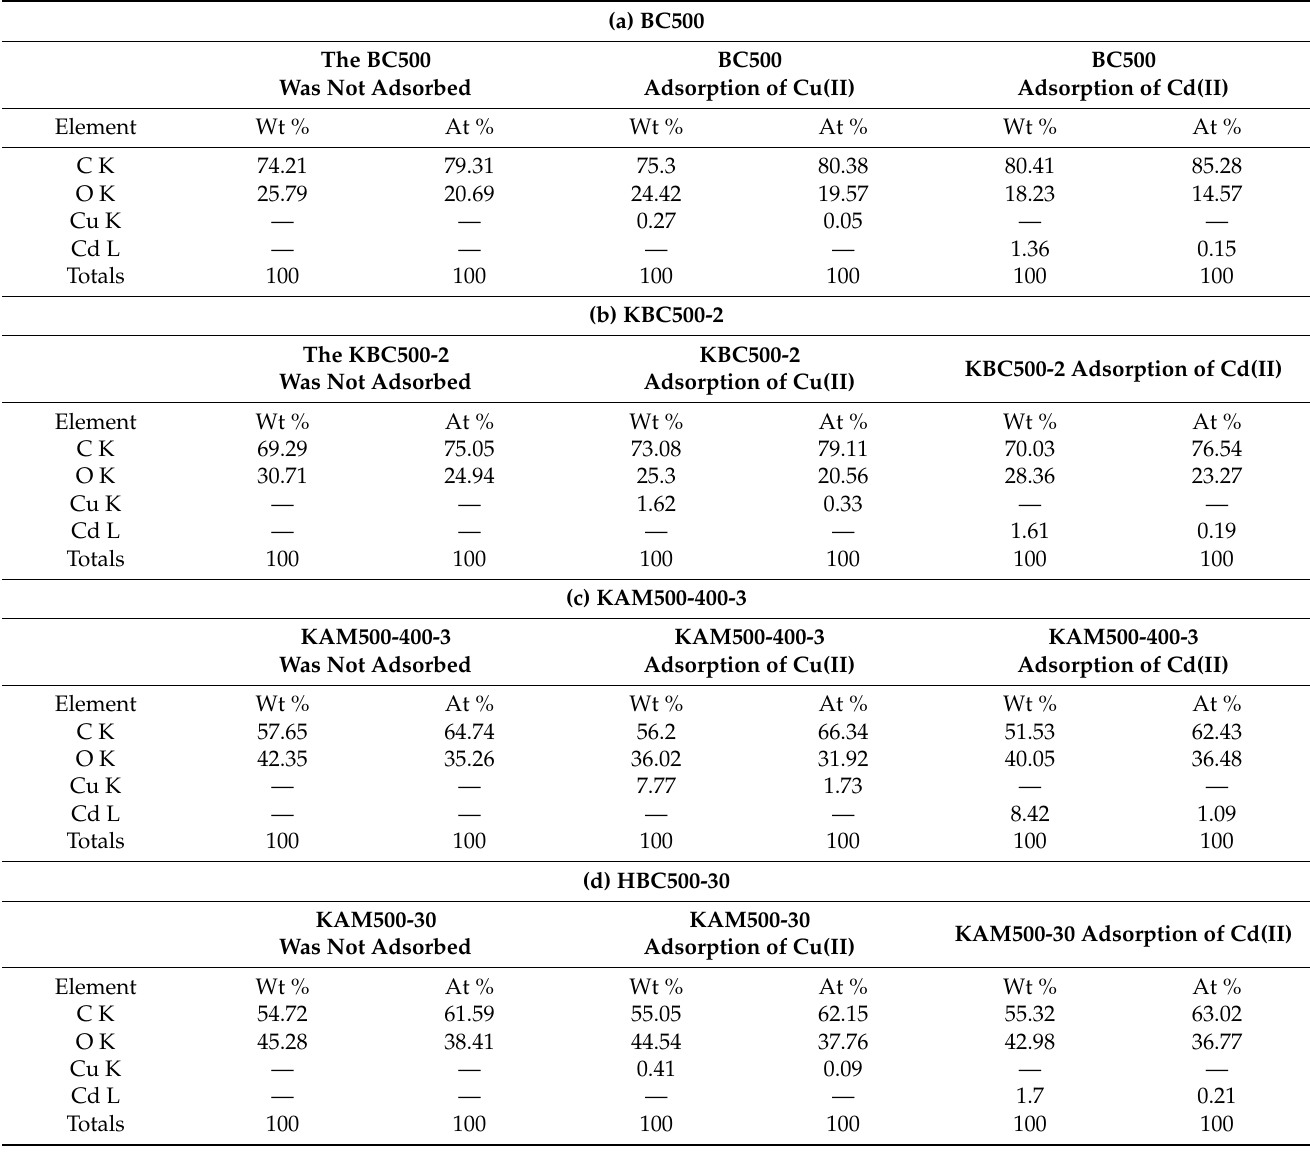
Table 5. Element distribution table before and after the adsorption of heavy metals Cu(II), Cu(II), and Cd by bamboo charcoal and modified bamboo